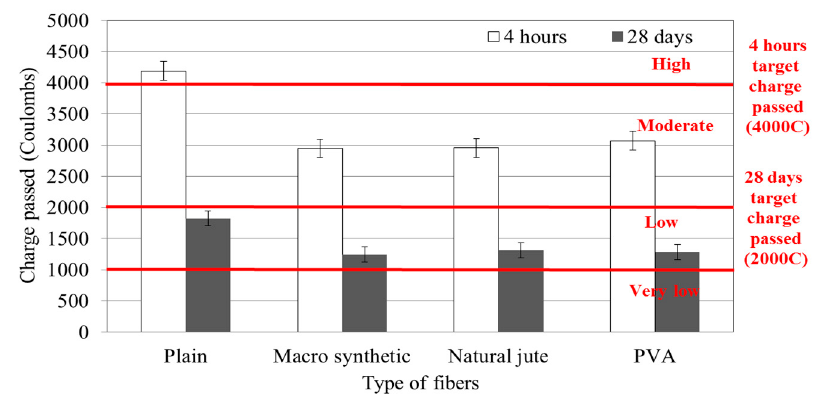
Figure 10. Chloride ion penetration test results.